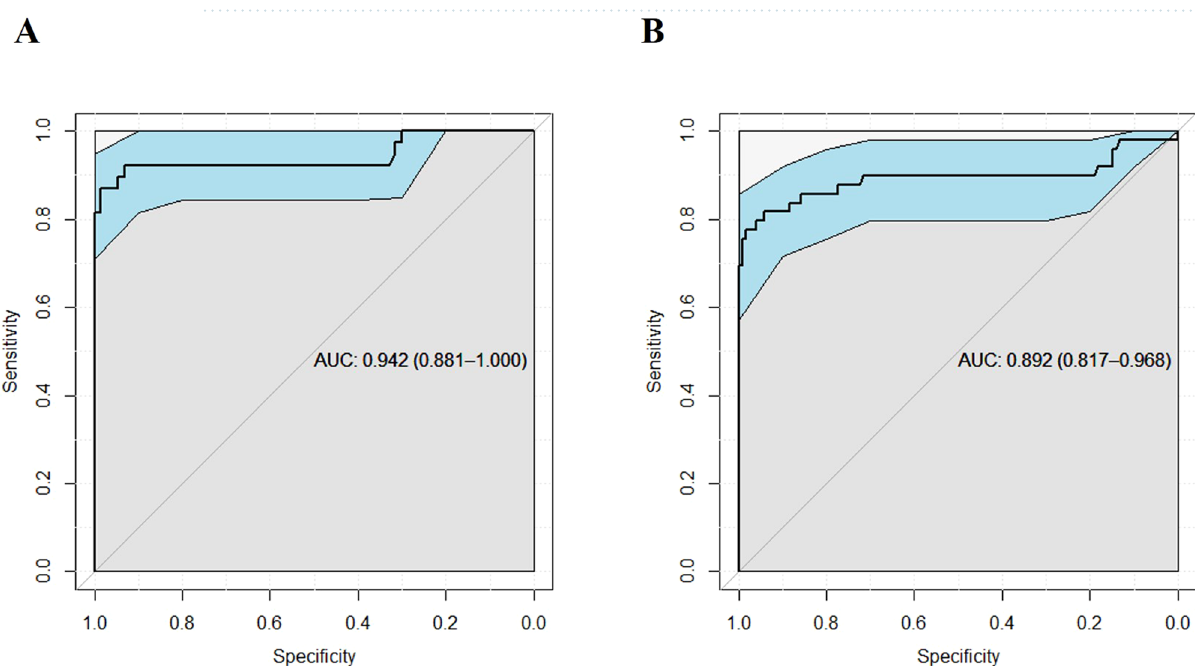
Figure 4. Co-localization of 53BP1and DDR-related molecules. Co-localization of 53BP1 (green) and p-ATM (orange) in follicular lymphoma grade 2 (A) , and 53BP1 (green) and γH2AX (orange) in mantle cell lymphoma, classical type (B) by dual-color immunofluorescence analyses. The images were photographed with the Z-stack function of Biorevo BZ-X710 microscope (Keyence Japan, Osaka, Japan), and their signals were analysed using the image analysis software provided with the Biorevo BZ-X710.